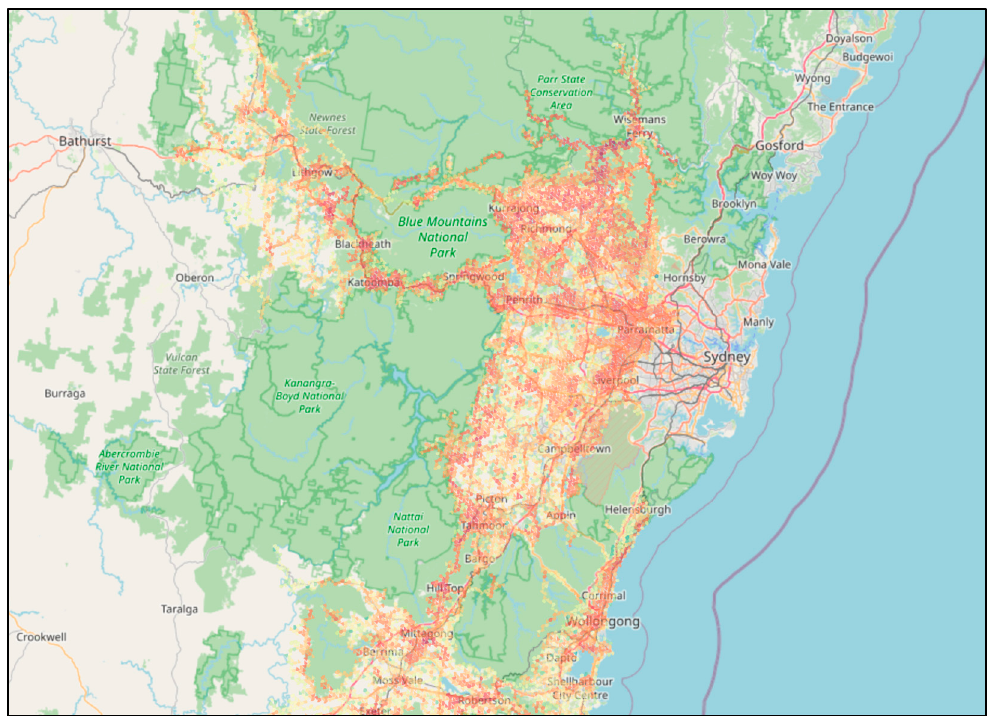
Figure 5. Ignition risk calculated over a 1 km hex grid across the network for the 2016–17 fire season. Darker red areas indicate a higher probability of an ignition event occurring. Only a subset of the network covers areas that are prone to bushfire, and as such, the above map should not be viewed as a bushfire risk map.